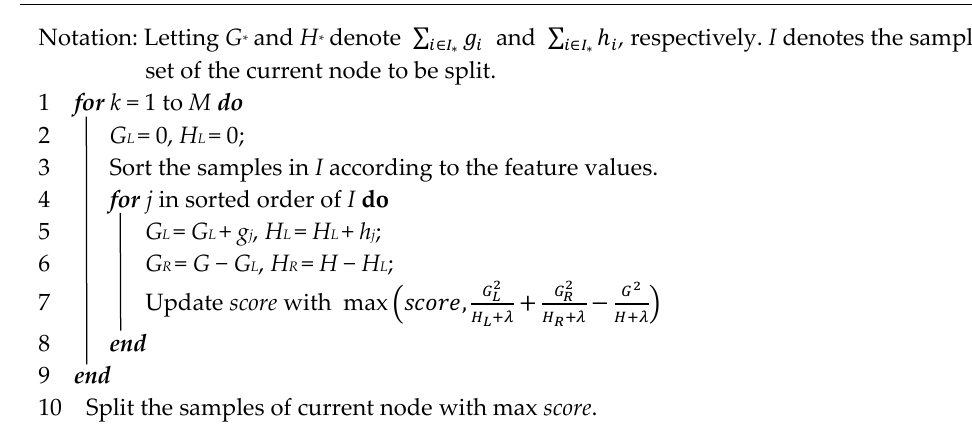
Algorithm 4: Exact greedy algorithm for CART construction in XGBoost [14].